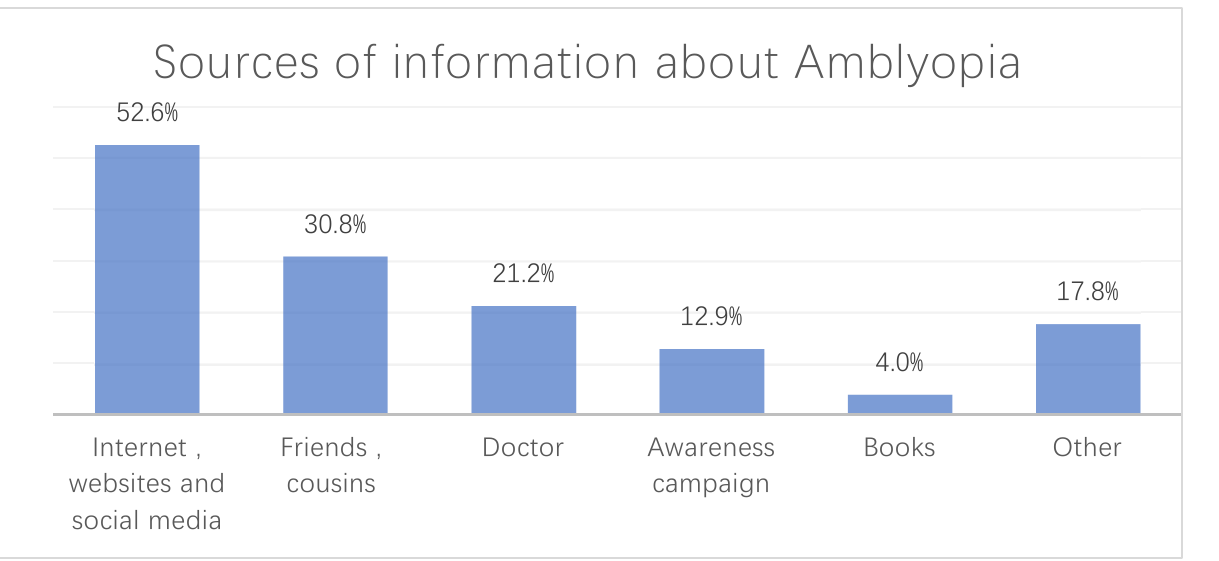
Figure 3. The most common sources of information regarding amblyopia.